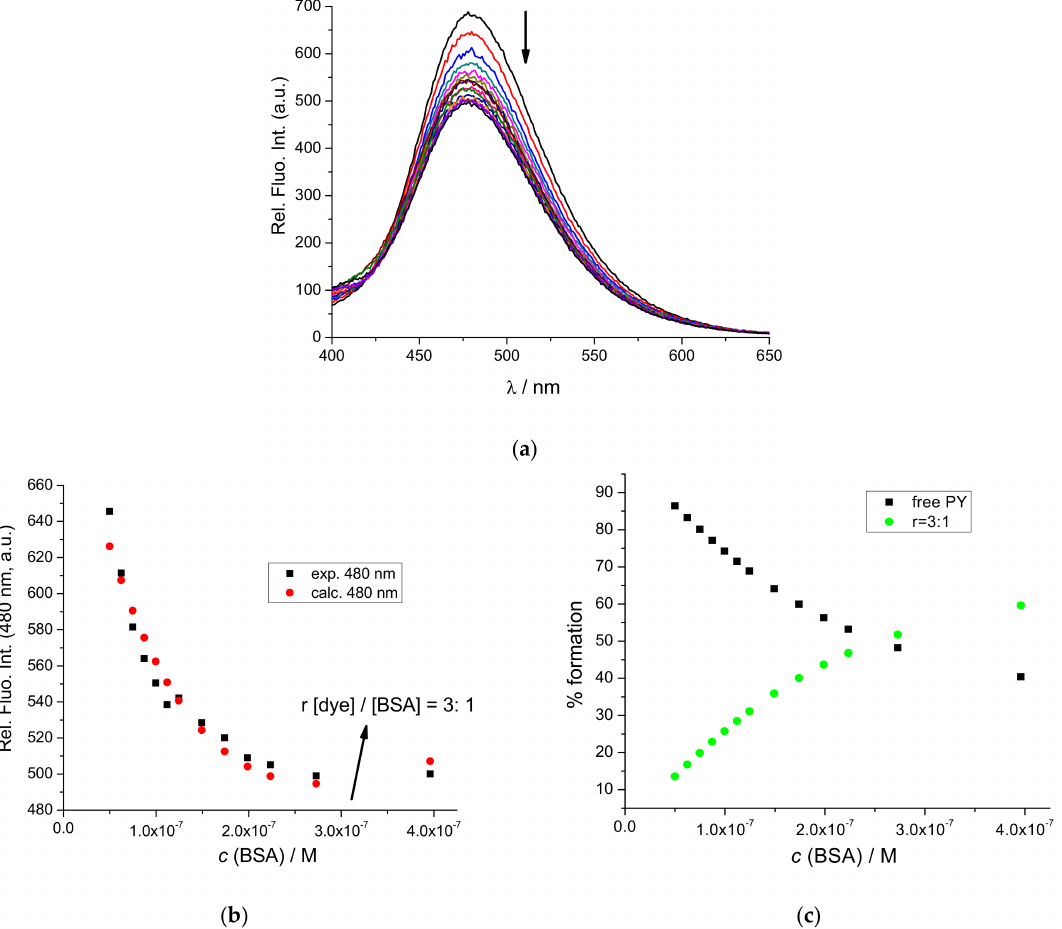
Figure 11. ( a ) Fluorimetric titration of DAE-NH-Py open ( c = 1 × 10 − 6 M; λ exc = 342 nm) with BSA; ( b ) Dependence of emission at λ max = 480 nm on c (BSA): experimental ( (cid:4) ) and HypSpec2014 [43] calculated data ( • ); ( c ) Distribution of spectroscopically active species dependent on a c (BSA) based on HypSpec2014 processing [43], free DAE-NH-Py open ( (cid:4) ); 3:1 complex ( • ). Done at pH 7.0, buffer sodium cacodylate, I = 0.05